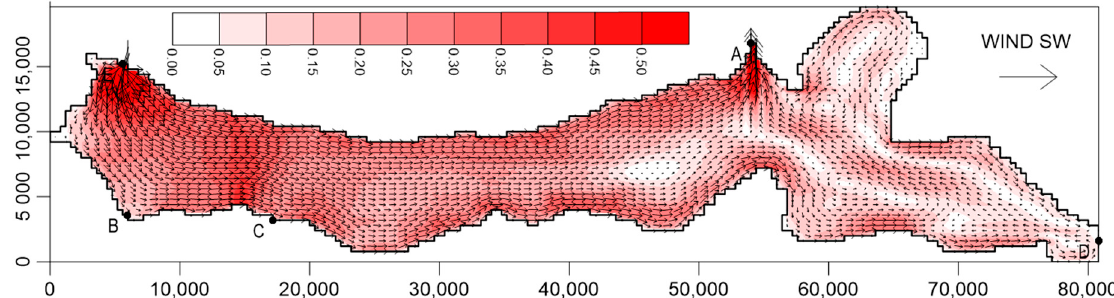
Figure 13. Water surface elevation (m a.s.l.) after 12 hours of a SW wind at a speed of 12 m s -1 and with the new artificial strait at point E (dimensions in meters).